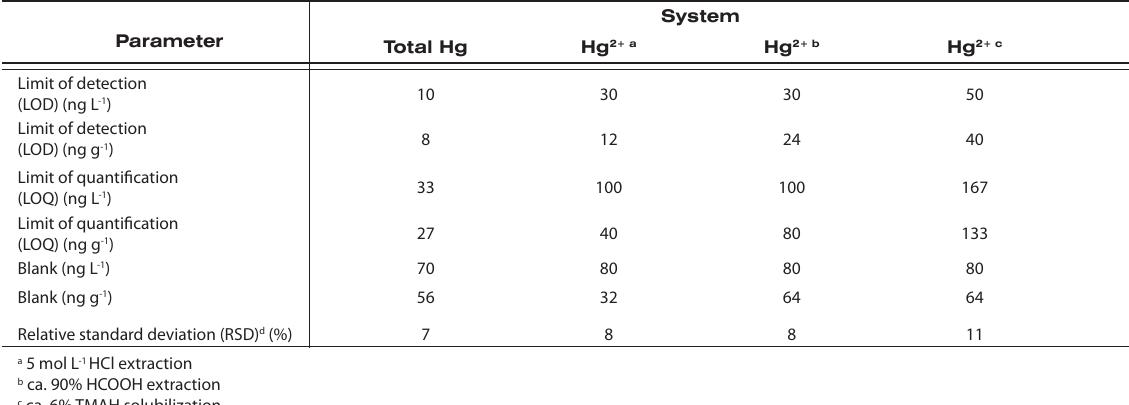
Table 3. Figures of merit for the determination of total mercury (Hg) and inorganic mercury (Hg 2+ ) in solutions by CVAAS.